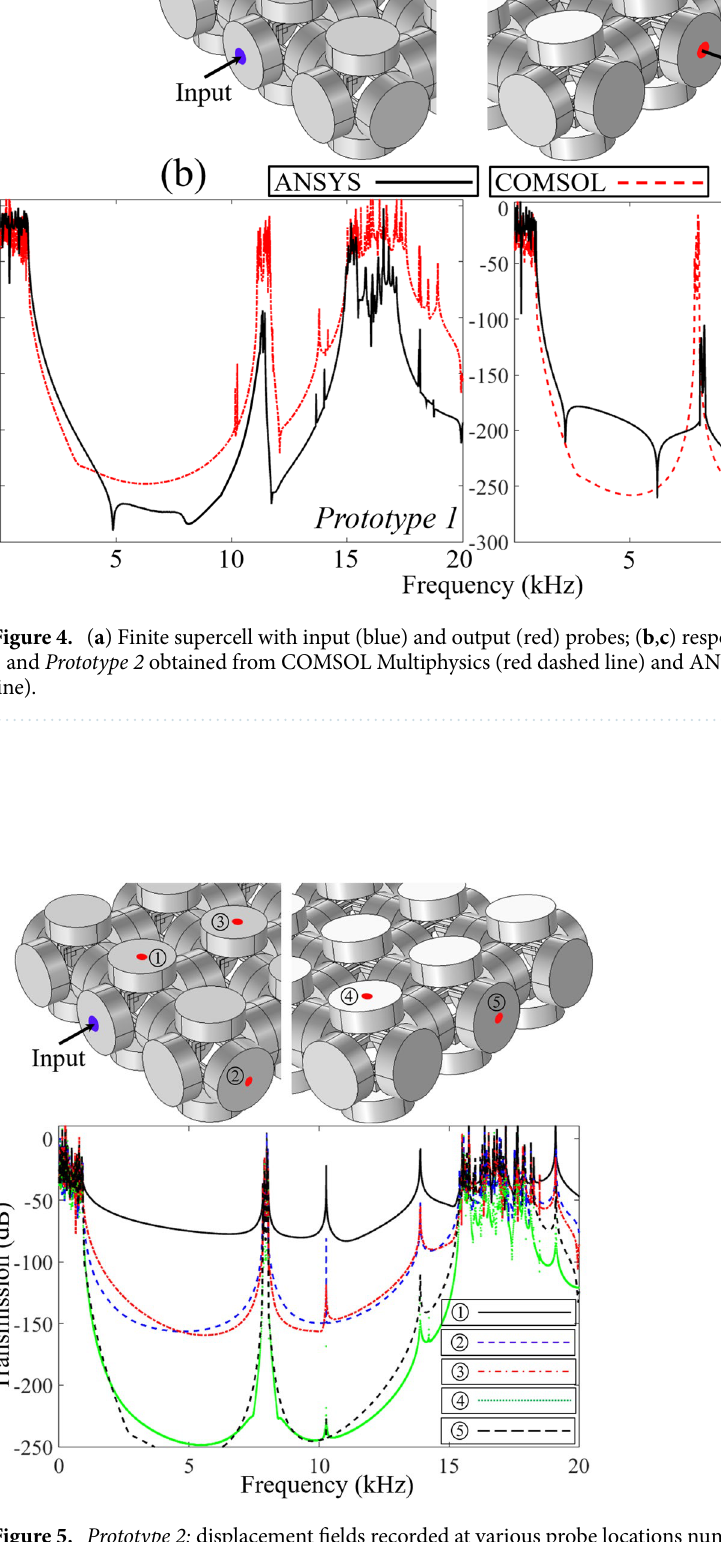
Figure 5. Prototype 2: displacement fields recorded at various probe locations numbered from 1 to 5. The BG width is independent of probe location while the attenuation depth increases if the point probe is away from the excitation